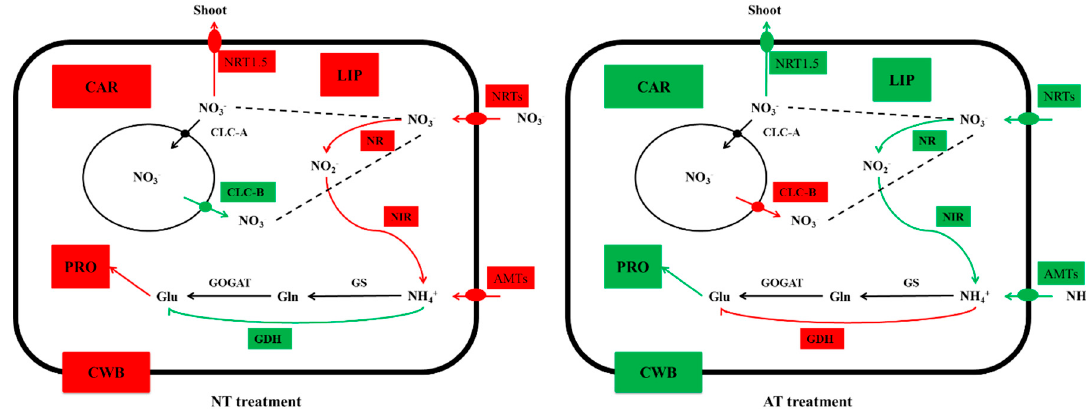
Figure 8. A proposed model for N metabolism and other primary metabolism in oilseed rape roots in NT and AT treatment groups. The colored rectangles indicate the following: red, N transporters, enzymes or physiological processes that increased; and green, N transporters, enzymes or physiological processes that decreased. Red or green solid arrows represent the strengthening or weakening of physiological processes, and black solid arrows represent physiological processes that did not significantly change. Compared with AT treatment, NT treatment led to upregulation of the NRT / AMT genes in roots and facilitated NO 3 − uptake. Simultaneously, NR and NIR activities increased, and BnNRT1.5 gene expression was upregulated, which facilitated more NO 3 − transport into shoots from roots for assimilation under NT treatment. This enhanced transport was beneficial for oilseed rape growth because NO 3 − assimilation e ffi ciency is known to be higher in shoots than in roots due to the utilization of solar energy by oilseed rape shoots. Furthermore, carbohydrate metabolism (CAR), lipid metabolism (LIP), protein metabolism (PRO), and CWB were promoted by NT treatment, which facilitated oilseed rape root growth and development. Thus, NT treatment was more beneficial to oilseed rape growth than was AT treatment.